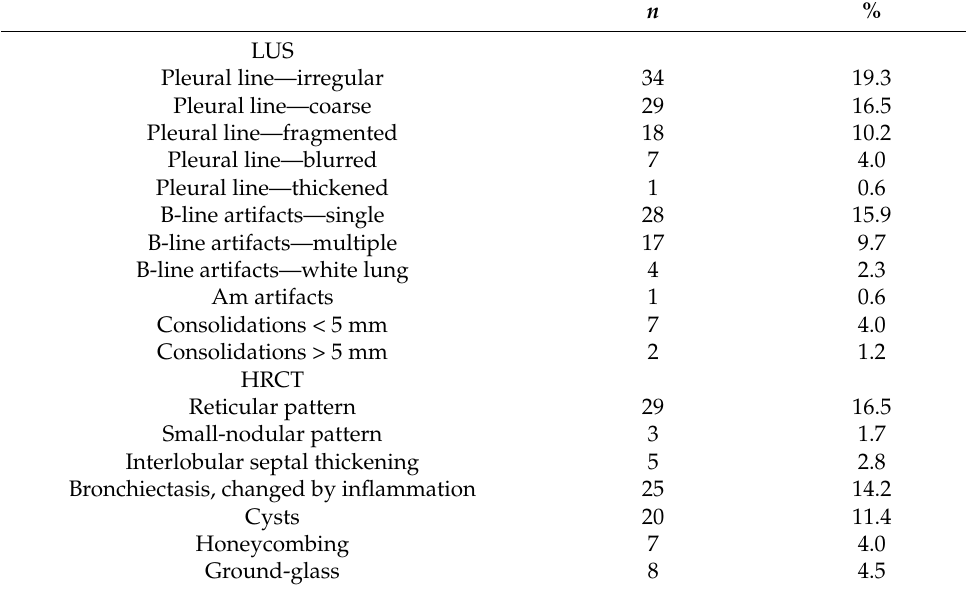
Table 3. Analysis of pulmonary lesions in LUS and CT. Definition used: Single B lines—less than three in one intercostal space; Multiple B lines—more than three in one intercostal space; White lung—numerous B lines, which merging in a one wide vertical artifact, fill up entire intercostal